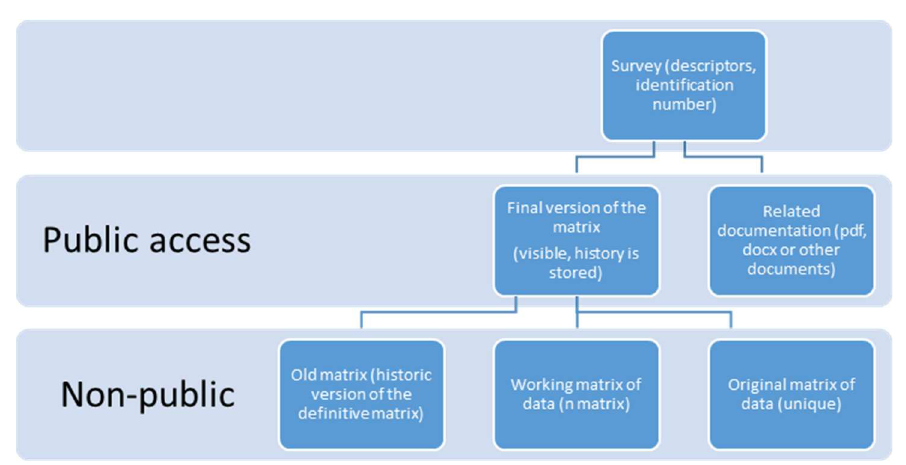
Figure 1. Life cycle of a study.